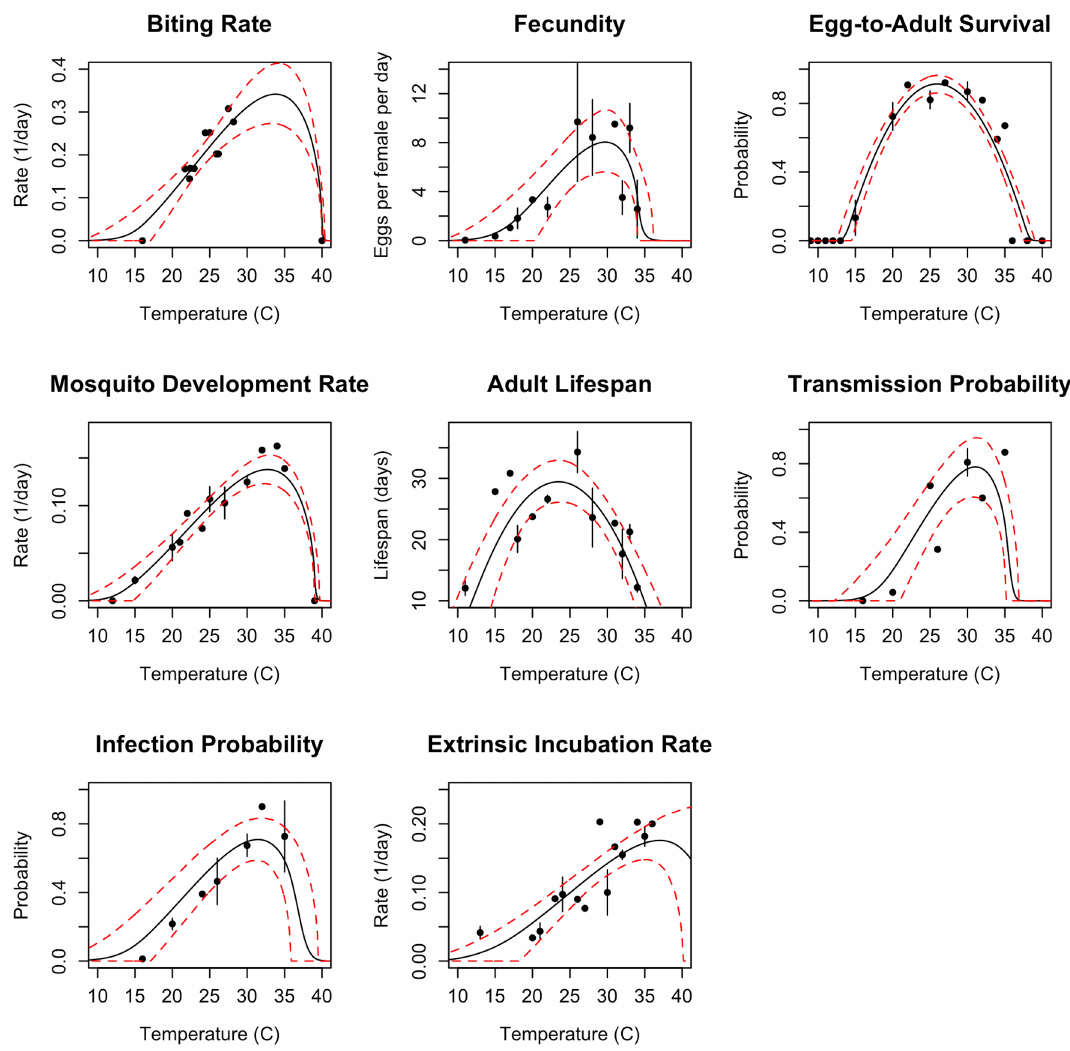
Fig 1. Thermal responses of Ae . aegypti and DENV traits that drive transmission (data sources listed in Table B in S2 Text). Informative priors based on data from additional Aedes spp. and flavivirus studies helpedto constrainuncertainty in the model fits (see Materialsand Methods; Table C in S2 Text). Points and error bars indicate the data means and standarderrors (for display only; models were fit from the raw data). Black solid lines are the mean model fits; red dashed lines are the 95% credibleintervals. Thermal responsesfor Ae . albopictus are shown in Fig A in S1